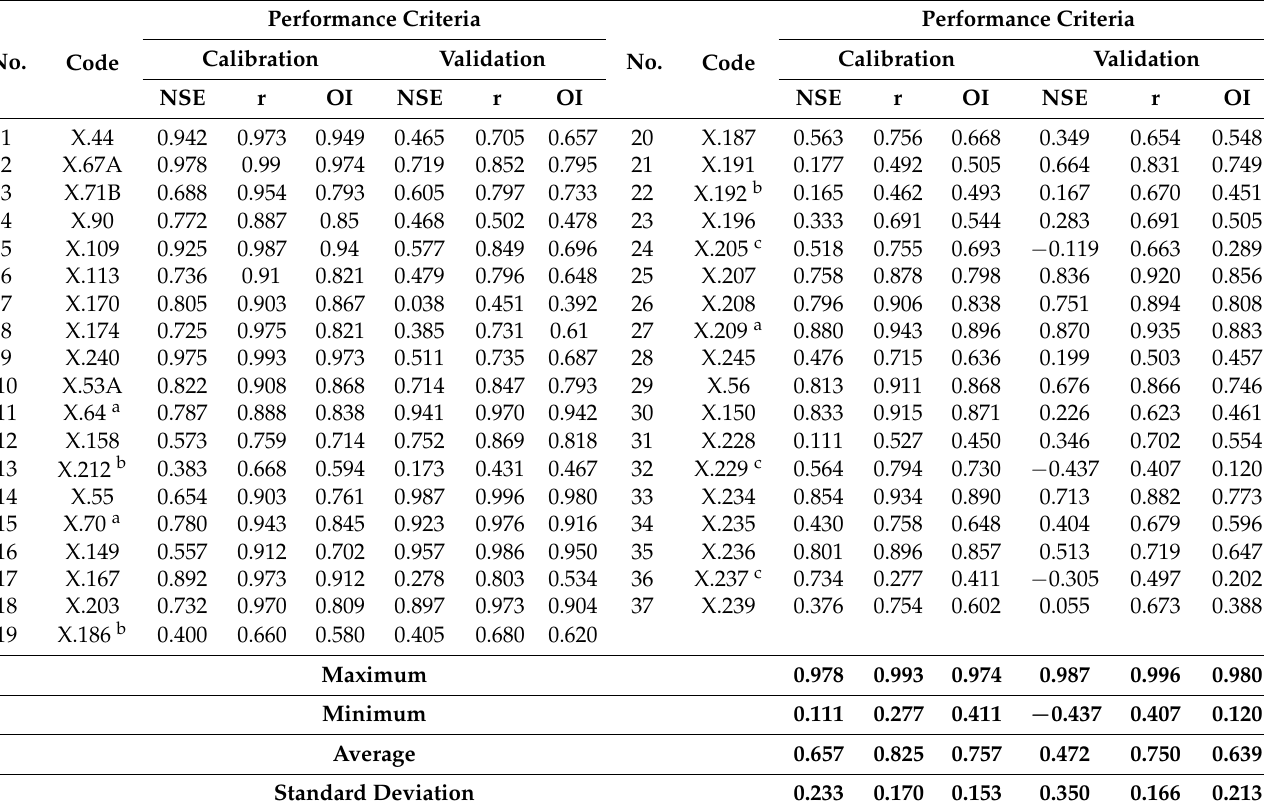
Table 2. Results of calibrating and verifying the GR2M